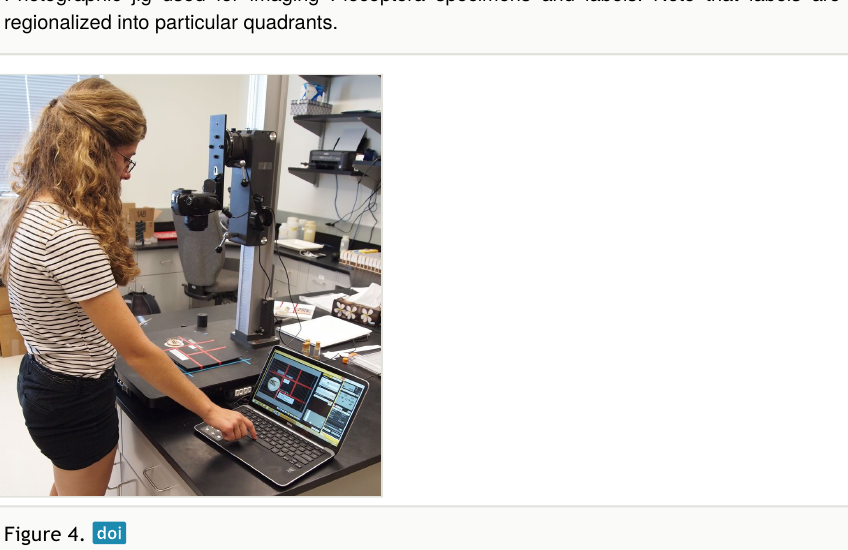
Photographic jig used for imaging Plecoptera specimens and labels. Note that labels are regionalized into particular quadrants.